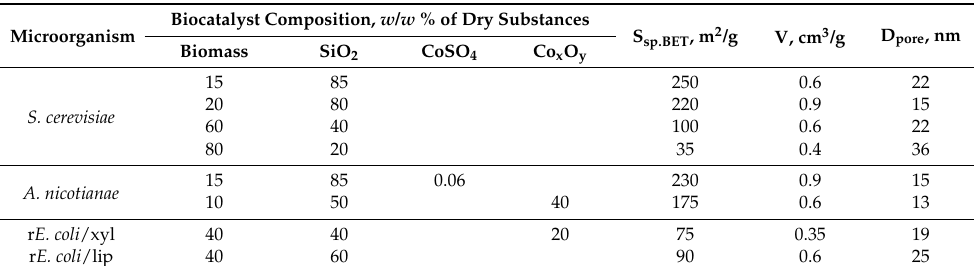
Table 2. Textural characteristics of the whole-cell biocatalysts depending on taxonomy of immobilized microorganisms and composition of the prepared multi-component biocatalysts.